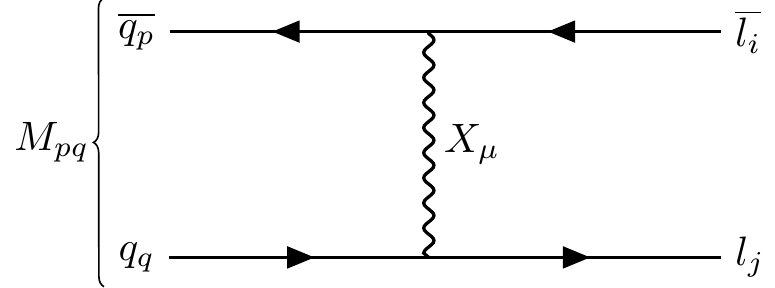
Figure 2 . Tree-level Feynman diagram of the leptonic decay of a scalar meson M pq , where q p and q q correspond to the valence quarks of the meson, to the lepton pair l i,j ( i, j = e, µ, τ ) mediated by the PS gauge leptoquark X . PS unifies quarks and leptons of similar isospin, therefore the µ processes mediated by X at tree-level are easily predicted, e.g. if q corresponds to an up-type µ q quark then l must be a neutrino. The strongest limits on the mass of X arise in the case where j µ p and q are both down-type quarks, where M pq = ( K 0 , B 0 , B 0 , . . . ) , and therefore the final state s L d comprises of charged leptons with opposite